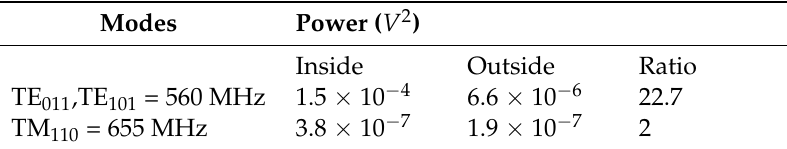
Table 7. Peak values for first TE and TM modes inside and outside the tank for surface PD in twisted